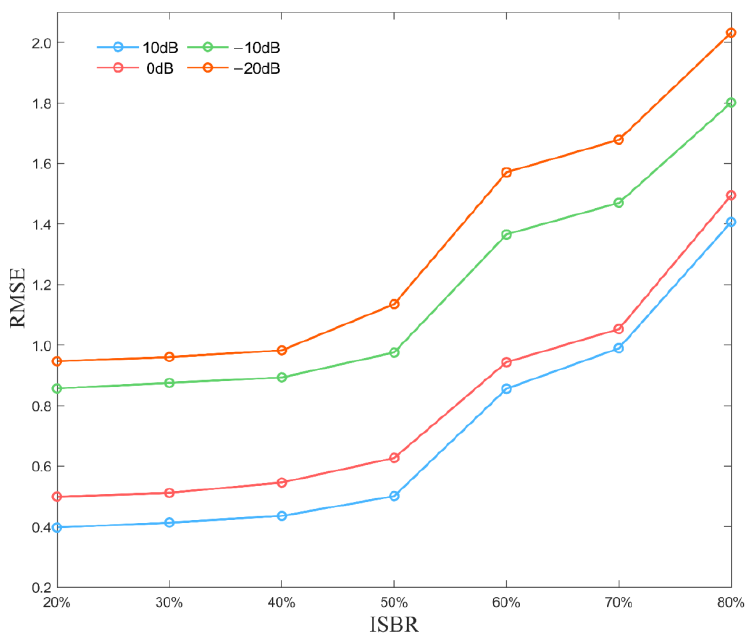
Figure 10. RMSEs with different SINRs when the ISBR varies from 20% to